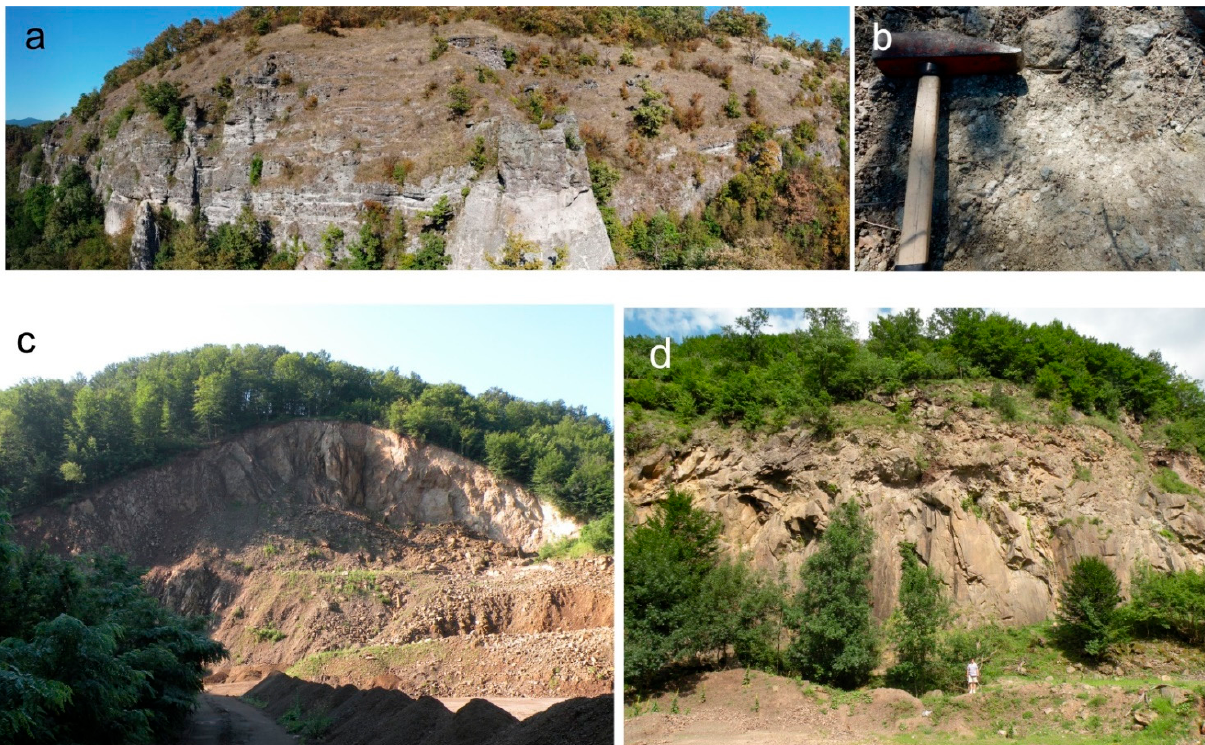
Figure 5. Geological features of the LDS: ( a ) Panoramic view of southern marginal part of the Gurahon ţ lava Dome complex; the view is showing ~50 m sequence of dm-m multiple layered deposits discernible by their whitish color. The whitish color indicates the pumice occurrence. The sequence belongs to the initiation of domes characterized by an initial multiple small-size Vulcanian explosive events and dome collapse; ( b ) Detail of a matrix-supported meter-sized deposit showing cm–dm sized angular andesitic clast and pumice, indicative of pumice and block ash flow deposits; ( c ) Detail with vertical jointing in one of the Gurahon ţ lava dome complex at Gura V ă ii; ( d ) Frequently vertical jointing at the margin of Vârfuri lava Dome complex in the top with marginal breccias at Vârfuri railroad station.